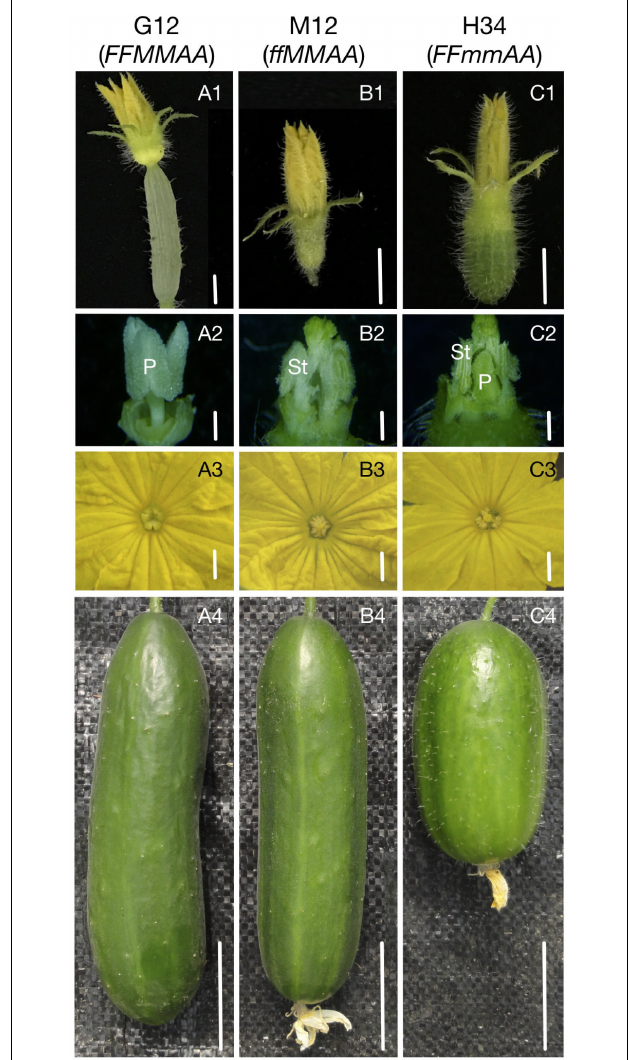
FIGURE 1 | Sex expression, flower, and fruit morphology of NILs. Flower organs showed different morphology between G12 ( FFMMAA ), M12 ( ffMMAA ), and H34 ( FFmmAA ). (A1–C1) Flowers before antheses. Bars = 0.5 cm, (A2–C2) Floral organ without petal and sepal. Bars = 0.2 cm, (A3–C3) Floral organ with petal. Bars = 0.2 cm, (A4–C4) Mature fruit. Bars = 4 cm. P, pistil; St,